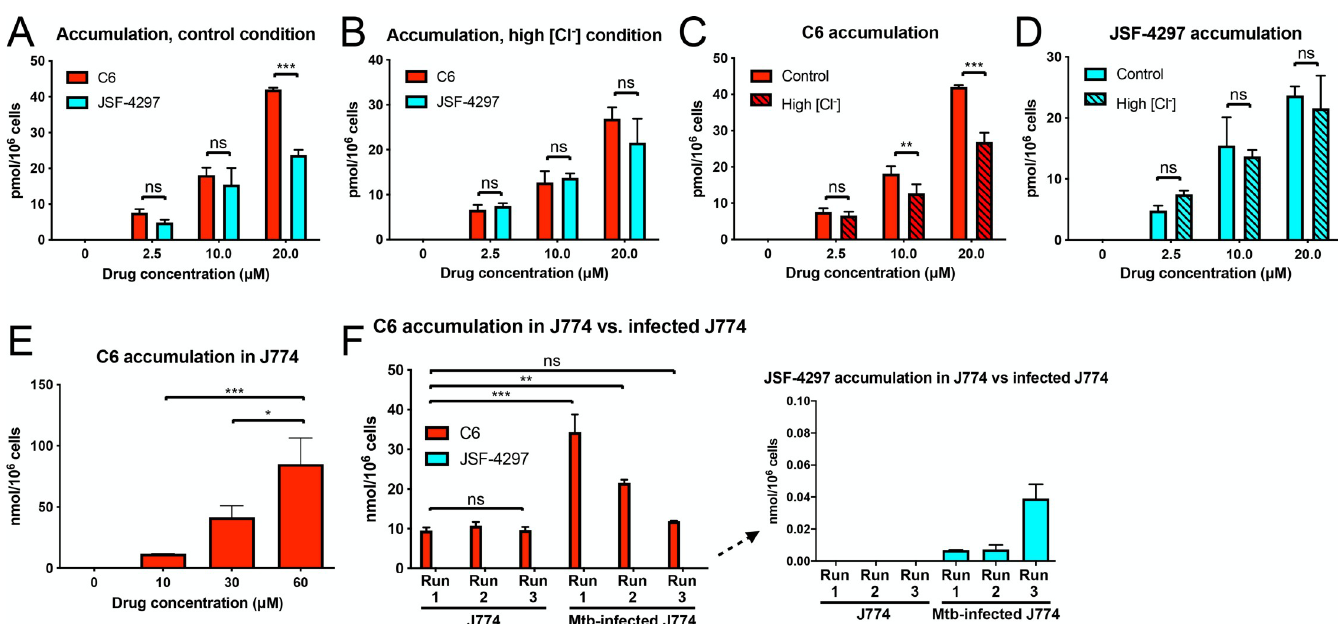
Fig 3. C6 accumulates in Mtb and host macrophages. (A–D) Intrabacterial accumulation of C6 is higher than the inactive analog JSF-4297. Mtb were grown in 7H9 (pH 7) ± 250 mM NaCl for 6 days, before 24-hour exposure to C6 or JSF-4297 and analysis of intrabacterial compound content. (A) and (B) show dose-dependent intrabacterial accumulation of C6 versus JSF-4297 under control and high [Cl − ] conditions, respectively. (C) and (D) show the same data but compare C6 or JSF-4297 accumulation under control versus high [Cl − ] conditions in each case. (E) Intracellular accumulation of C6. J774 cells were exposed to indicated concentrations of C6 for 24 hours, before analysis of the samples for intracellular compound content. (F) C6 accumulation during Mtb infection of J774 cells. J774 cells were infected with Mtb for 5 days, before treatment with 10 μ M of indicated compound for 24 hours, sample collection and analysis for total compound accumulation (within both J774 cells and bacteria within the J774 host cells). For (A–E), data are shown as means ± SD from 2–3 samples, representative of 2 independent experiments. In (F), data are shown as means ± SD from 2–3 wells, from 3 independent experiments. p -values were determined by one- (E) or two-way (A–D, F) ANOVA with Bonferroni post hoc test for all assays. ns p > 0.05, � p < 0.05, �� p < 0.01, ��� p < 0.001. The amount of accumulated compound as the number of moles was normalized by the cell number (Mtb or J774) prior to compound incubation. The numerical data underlying the graphs shown in this figure are provided in S1 Data. Mtb, Mycobacterium tuberculosis ; ns, not